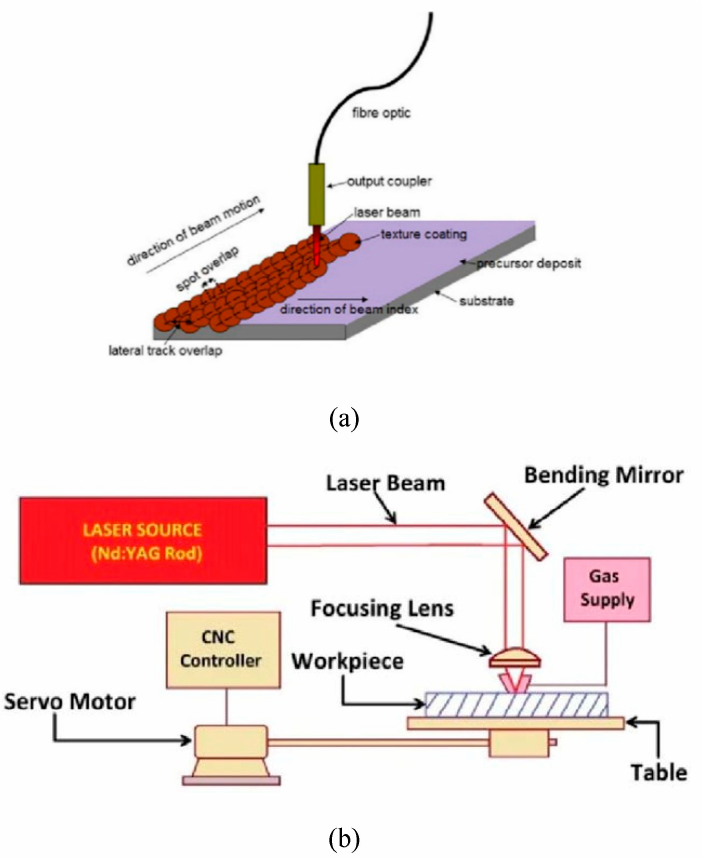
Figure 1. ( a ) Schematic of laser texturing process using pulsed laser [11] ( b ) and the laser cutting process